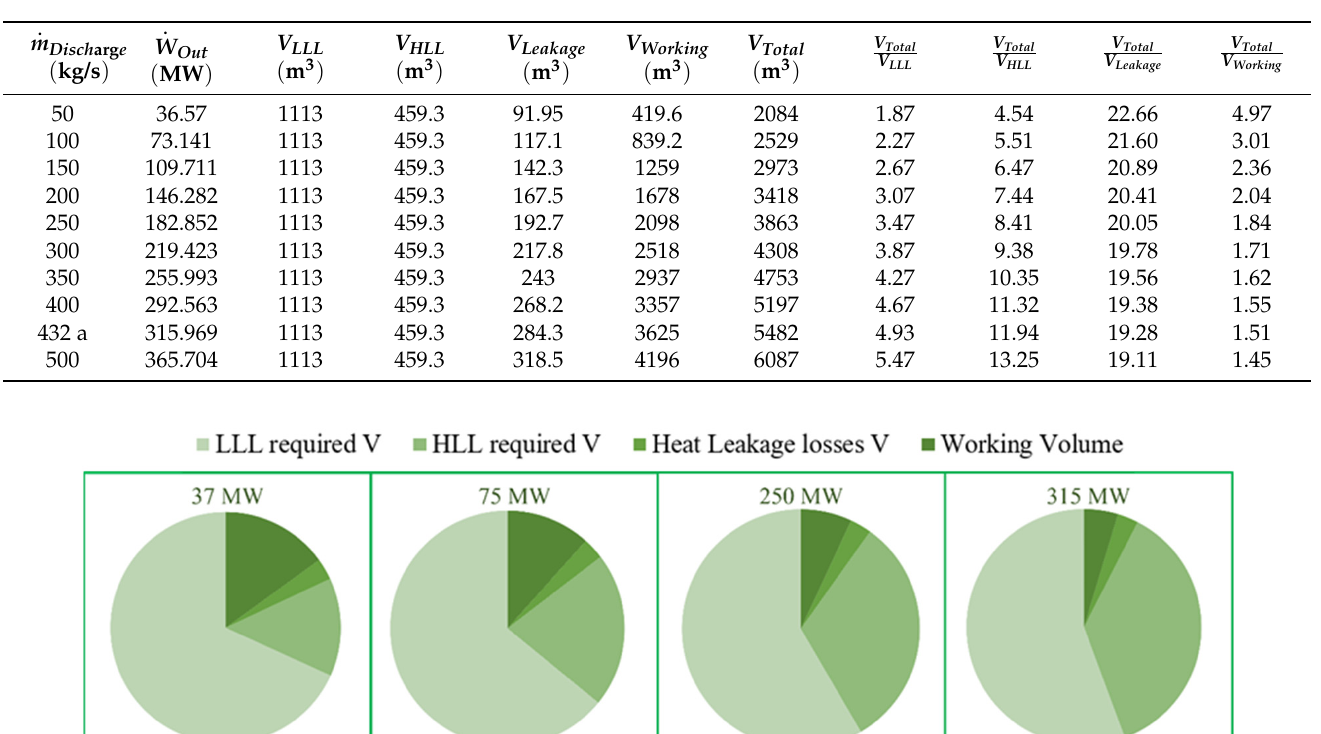
Table 4. Results for the different extra volumes that are required for the storage of liquid in specified output power. Letter (a) indicates the power applied for black starts in the Huntorf CAES plan.